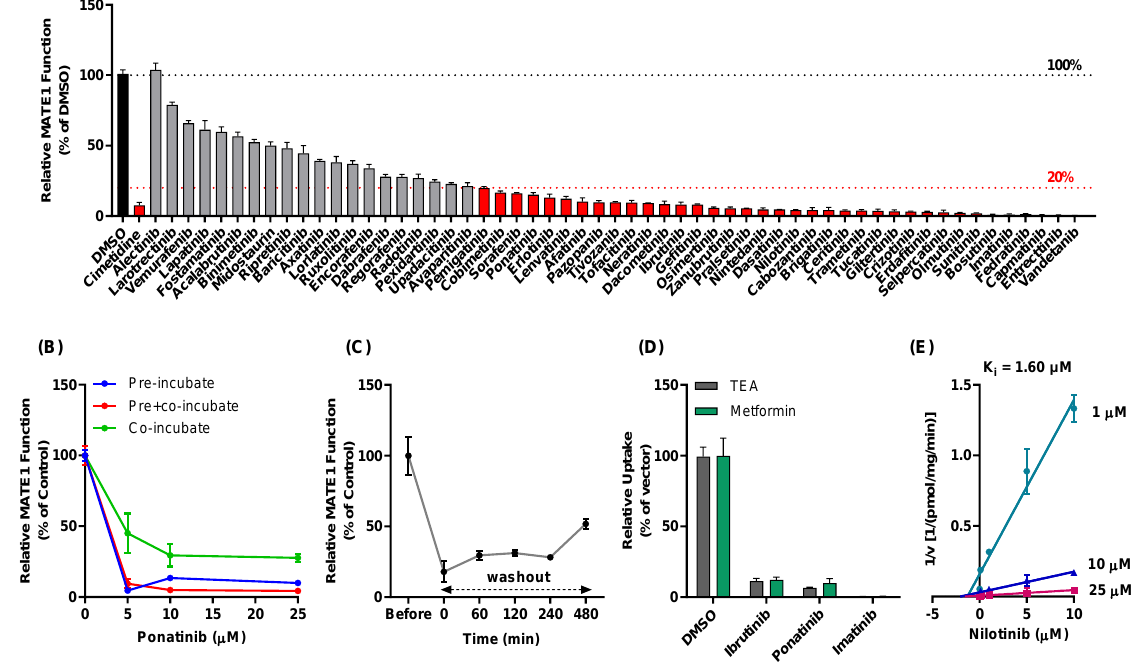
Figure 1. Modulation of MATE1 function by TKIs in vitro. ( A ) Different TKIs were tested at a concentration of 10 µM in both MATE1-overexpressing HEK293 cells and HEK293 cells transfected with an empty vector. The uptake of the MATE1 substrate [ 14 C] TEA (2 µM) in the presence of TKIs is reported as a percent difference of uptake in cells treated with the control vehicle, DMSO. Cimetidine (25 µM) was used as a positive control inhibitor of MATE1. ( B ) HEK293 cells overexpressing MATE1 were either pre-treated with TKI (ponatinib) for 15 min before adding the substrate TEA (pre-incubate group), co-incubated with TKI and TEA (co-incubate group), or pre-treated with TKI, followed by TEA in the presence of TKI (pre + co-incubate group). ( C ) Time-dependent recovery of MATE1 function in cells pre-incubated with ibrutinib 10 µM) for 15 min, followed by removal of ibrutiniband [ 14 C] TEA uptake assay was carried out at time 0, 1, 2, 4, and 8 h. Baseline MATE1 function was determined in untreated cells. ( D ) Influence of TKIs (pre + co-incubation) on comparative MATE1-dependent transport of [ 14 C] TEA (2 µM) and metformin (5 µM). The graph represents relative uptake as compared to individual vector group after normalization of protein levels. Individual t-tests showed no significant difference between the two substrates. ( E ) Dixon plot of nilotinib-dependent MATE1 inhibition of varying concentrations of [ 14 C] TEA. The velocity (v) was calculated based on the difference in uptake between cells with and without MATE1 overexpression. Data are shown as mean ± SEM.